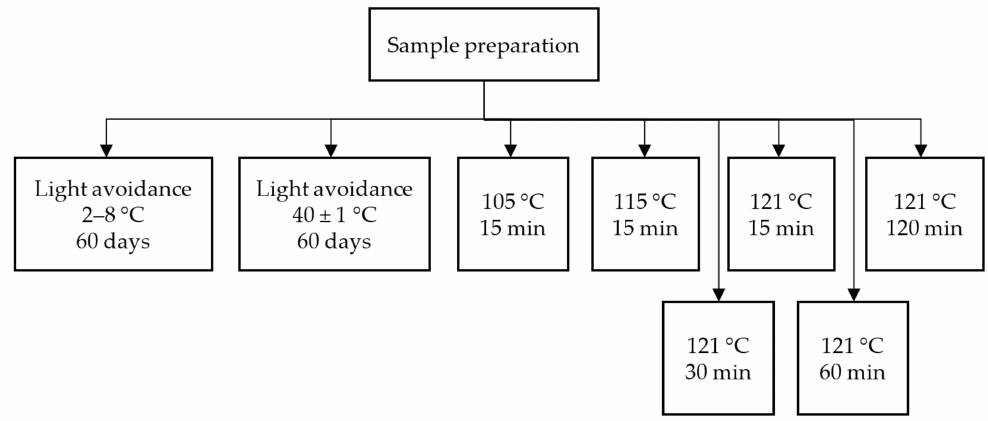
Figure 8. The experiment program of sample preparation in the temperature and isomerization